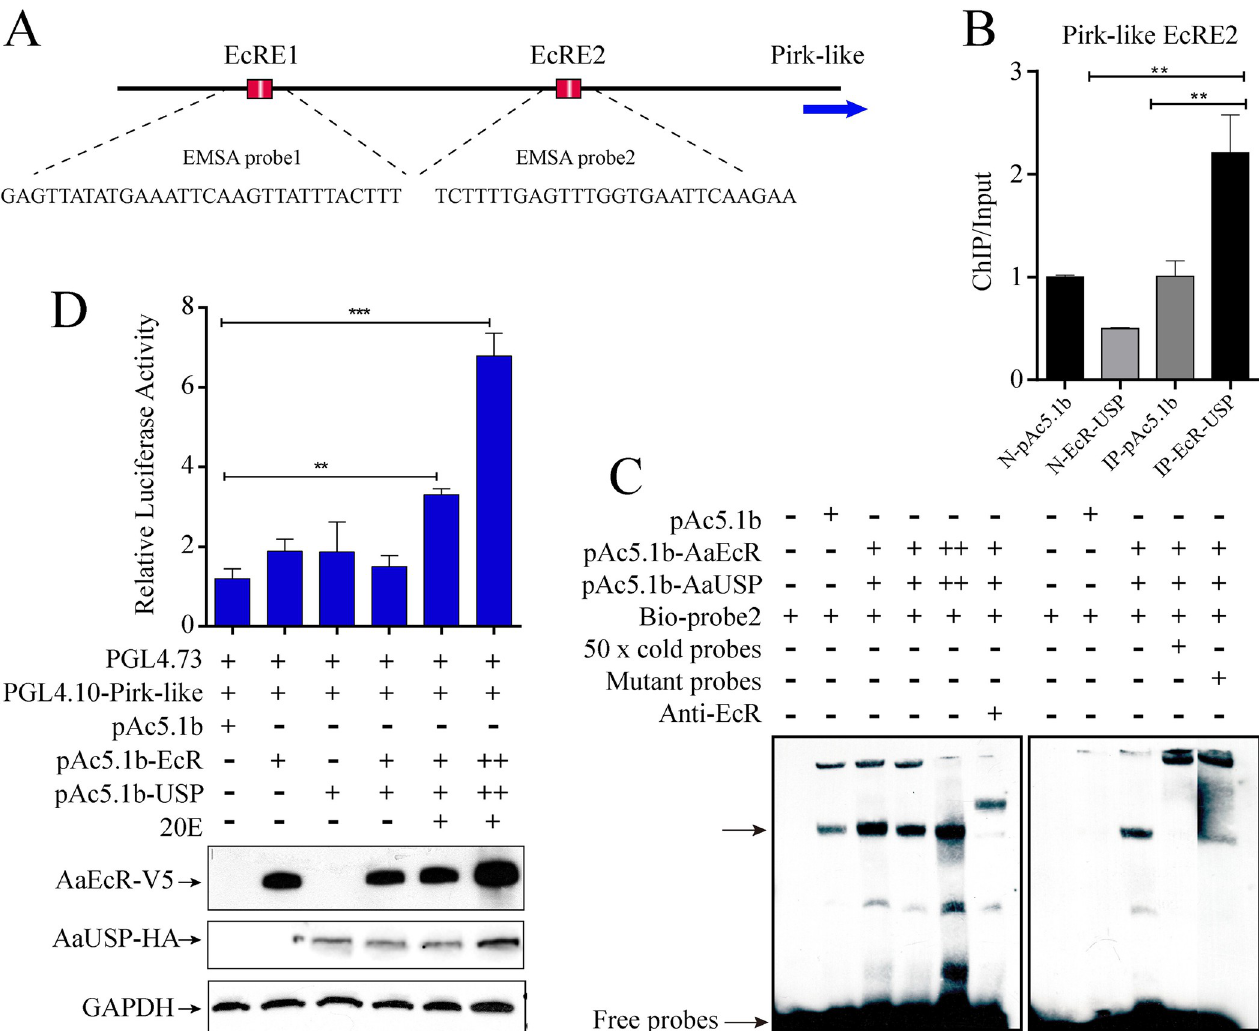
Fig 4. 20E-EcR-USP directly binds to the EcRE motif of Pirk-like. (A) Schematic showing Pirk-like promoter and putative 20E-EcR-USP binding motifs. EcRE1 and EcRE2 represent regional target sites tested in ChIP-qPCR analysis. (B) ChIP-qPCR analysis with EcR and USP co-expressed Aag2 cells using V5 antibody. pAc5.1b lysates incubated with mouse IgG antibody (N-pAc5.1b) or anti-V5 (IP-pAc5.1b) and EcR-USP lysates incubated with mouse IgG antibody (N-EcR-USP) were included as controls. n = 3 biological replicates. (C) EMSA results showing the binding of EcR to a biotin-labeled EcRE2 probe. Nuclear protein extracts from EcR- and USP-overexpressed Aag2 cells. Competitor (unlabeled 26-bp probe), mutant competitor and anti-EcR antibody were added as indicated. (D) Dual-luciferase reporter assay revealed the transcriptional activation of Pirk-like promoter in EcR- and USP-overexpressed S2 cells with 20E treatment. S2 cells were co-transfected with the reporter vector pGL4.10-Pirk (100 ng), the overexpression vectors (pAc5.1b-EcR/V5 and pAc5.1b-USP/HA, 100 ng), and the pGL4.73 plasmid (15 ng). The relative luciferase activity was detected at 48 h after transfection. Western blots were used to analyze the protein level of EcR and USP using V5 and HA antibodies. GAPDH was used as the